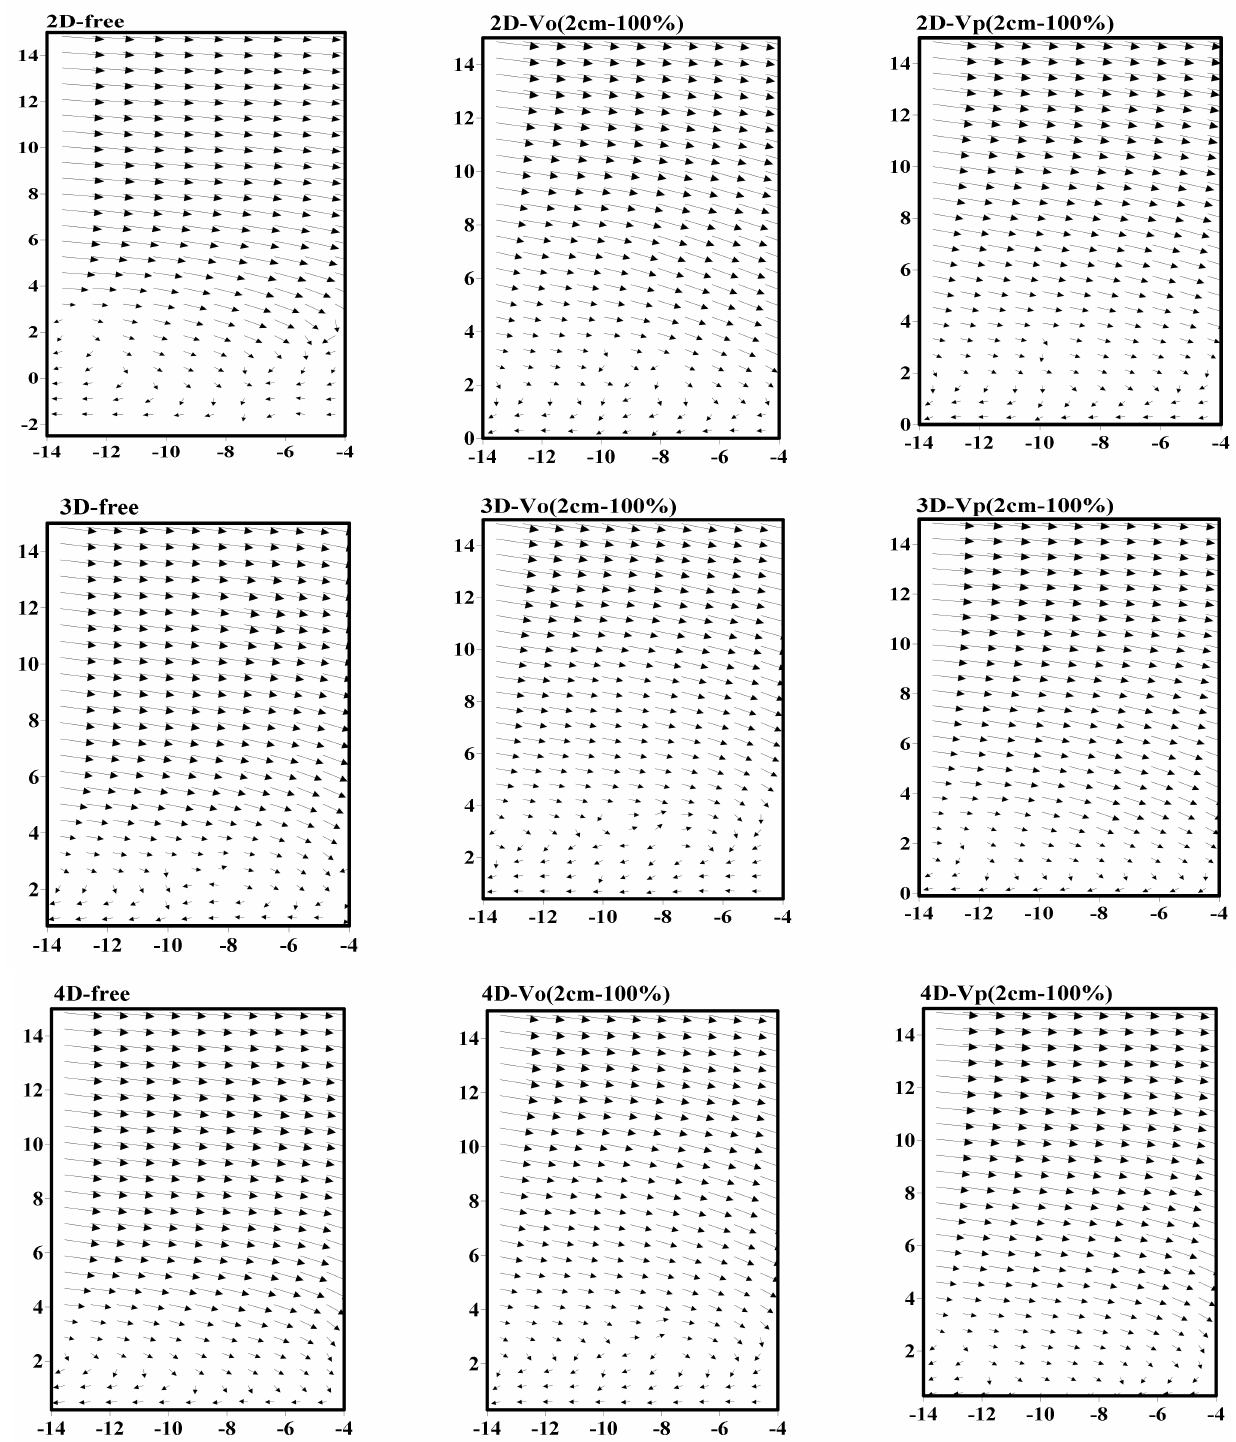
Figure 11. The X–Z resultant velocity vector on the center axis of the channel upstream of the first pile in the pile group